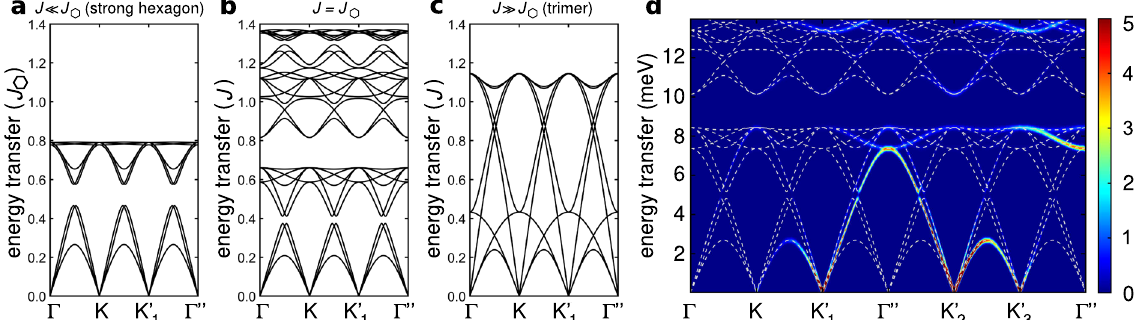
Fig. 3 Spin wave theory results. Calculated spin-wave dispersion within linear spin-wave theory along the ( ξ , ξ )-direction [from Γ to Γ ″ , in Fig. 1b] for three different cases: a J / J ⬡ = 1/5, b J / J ⬡ = 1, c J / J ⬡ = 25, where we set J 0 ¼ 0 in each case. For all the choices of couplings ! ¼ ð 1 = 3 ; 1 = 3 Þ ordered phase. The energy scale is set by J considered here, the system is in the Q ⬡ in panel ( a ), and by J in panels ( b ) and ( c ). We note that in the J ≪ J ⬡ ( a ) and J = J ⬡ ( b ) cases the lowest band (three-times folded) is separated from the higher bands by an energy gap. This gap closes upon increasing the ratio J / J ⬡ . d Calculated spin-wave dispersion and intensity within linear spin wave theory along the path Γ – K – – Γ ″ – K 0 – K 0 – Γ ″ [see Fig. 1b] for the ab initio estimated Heisenberg couplings J = 154.4 K, J = 134.2 K and J 0 ¼ 8 : 7 K ( S K 0 ⬡ XRD structure). The 1 2 3 spectral intensity is given by the perpendicular component of the spin dynamical structure factor, which is related to the cross section of unpolarized neutron scattering experiments 70 (the overall color scale is in arbitrary units). The low-energy spectral intensity at the K 0 ( K 0 ) 1 3 point is approximately 40% (20%) of the maximal intensity, located at the K 0 point. We apply a Gaussian broadening with a standard deviation 2 of 0.2